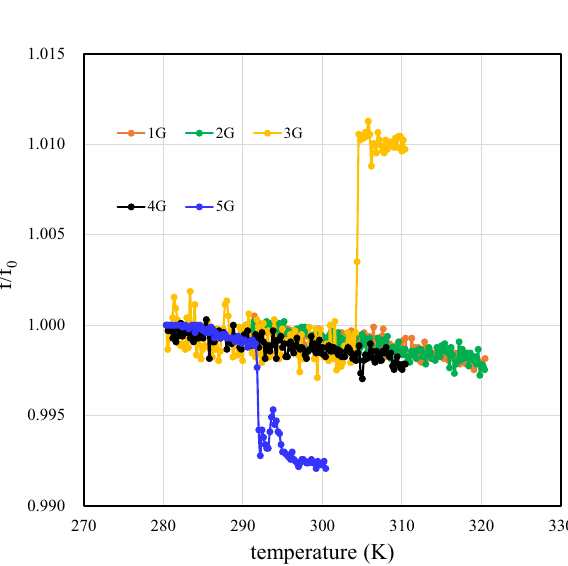
Figure 9. The fundamental frequencies of a SAW device with a tri-graphene/LiNbO 3 structure at temperatures of 300 K, 302 K, 304 K, 306 K, 308 K, and 310 K as functions of the DC voltage of the input IDT electrode.